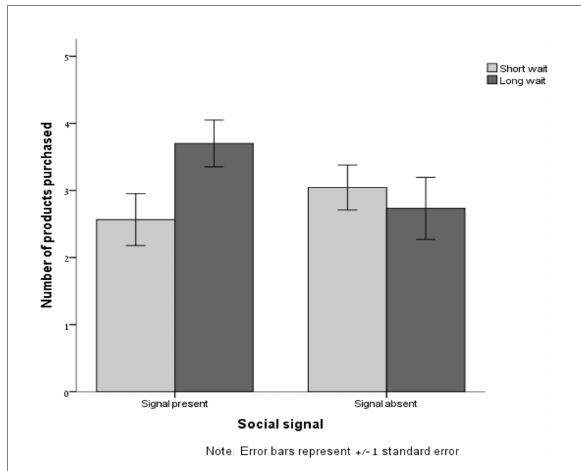
FIGURE 4 Number of snacks purchased as a function of wait duration (short vs. long) and availability of social signal (present vs. absent; Study 3b).